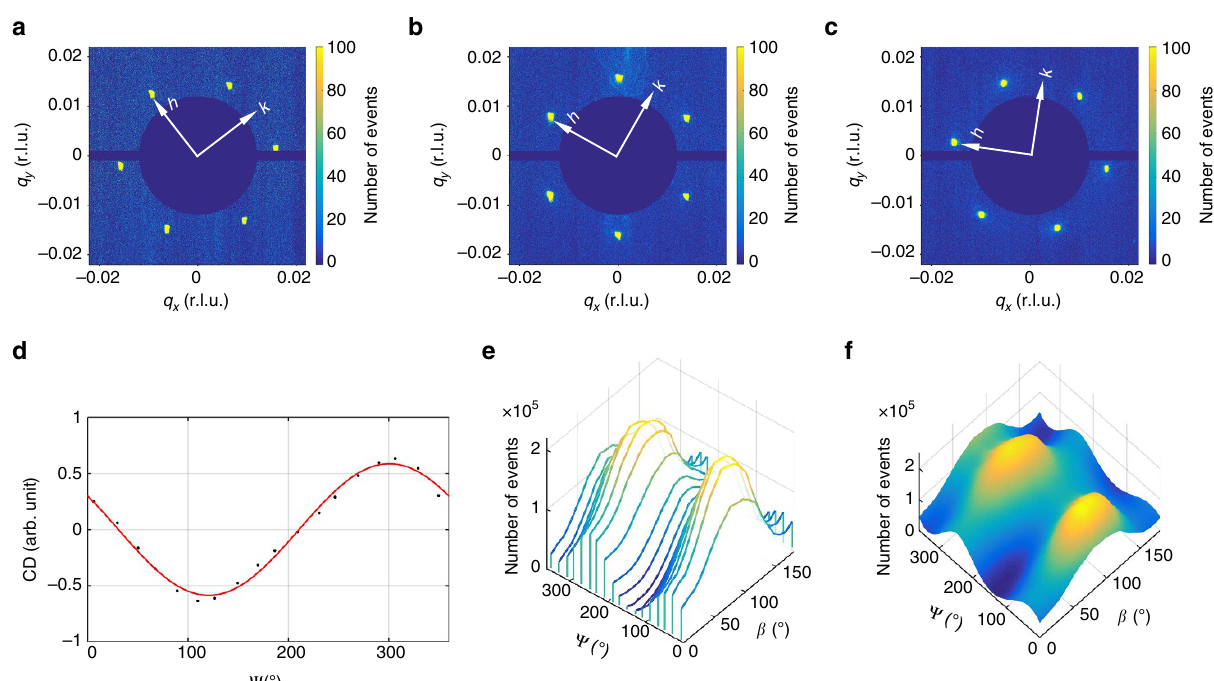
Figure 3 | Experimental determination of the topological winding number. ( a – c ) Resonant soft X-ray magnetic diffraction from Cu 2 OSeO 3 for three different azimuthal angles: C ¼ 5.95 (cid:2) , 29.56 (cid:2) and 50.17 (cid:2) , respectively. The photon energy is tuned to 931.25eV and the magnetic satellites are observed around the (001) structural peak. The figures show the reciprocal space maps within the ( hk 1)-plane, obtained by integrating the scattering intensities for left- and right-circularly polarized incident light. The coordinate system is defined in Fig. 1d. The temperature was 57K and the applied magnetic field of 32mTalong the z direction, which is also parallel to the [001] crystallographic direction. ( d ) CD signal as a function of C . The black dots are the measured data, while the red line is a fit using equation (3). ( e ) Measured PAM, and ( f ) interpolation obtained by fitting equation (4). The interpolated PAM shows excellent agreement with the calculated result shown in Fig. 2i, in which two humps of equal height can be observed at b E 90 (cid:2)